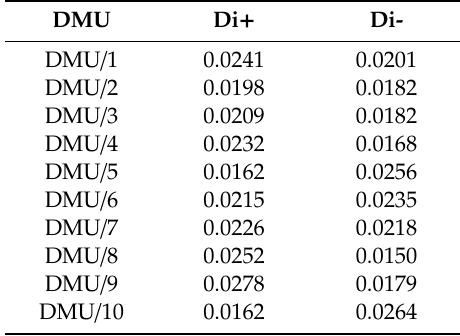
Table 9. Negative ideal solution (NIS) and positive ideal solution (PIS)